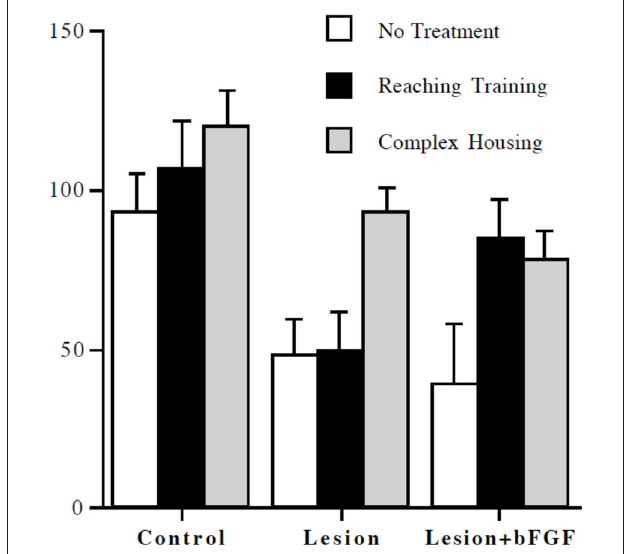
FigurE 3 | reaching accuracy expressed as a percent of preoperative performance level. Complex housing improved performance in all groups. Reaching training was effective only in combination with infusion of basic fibroblast growth factor (bFGF) (from Witt-Lajeunesse et al.,